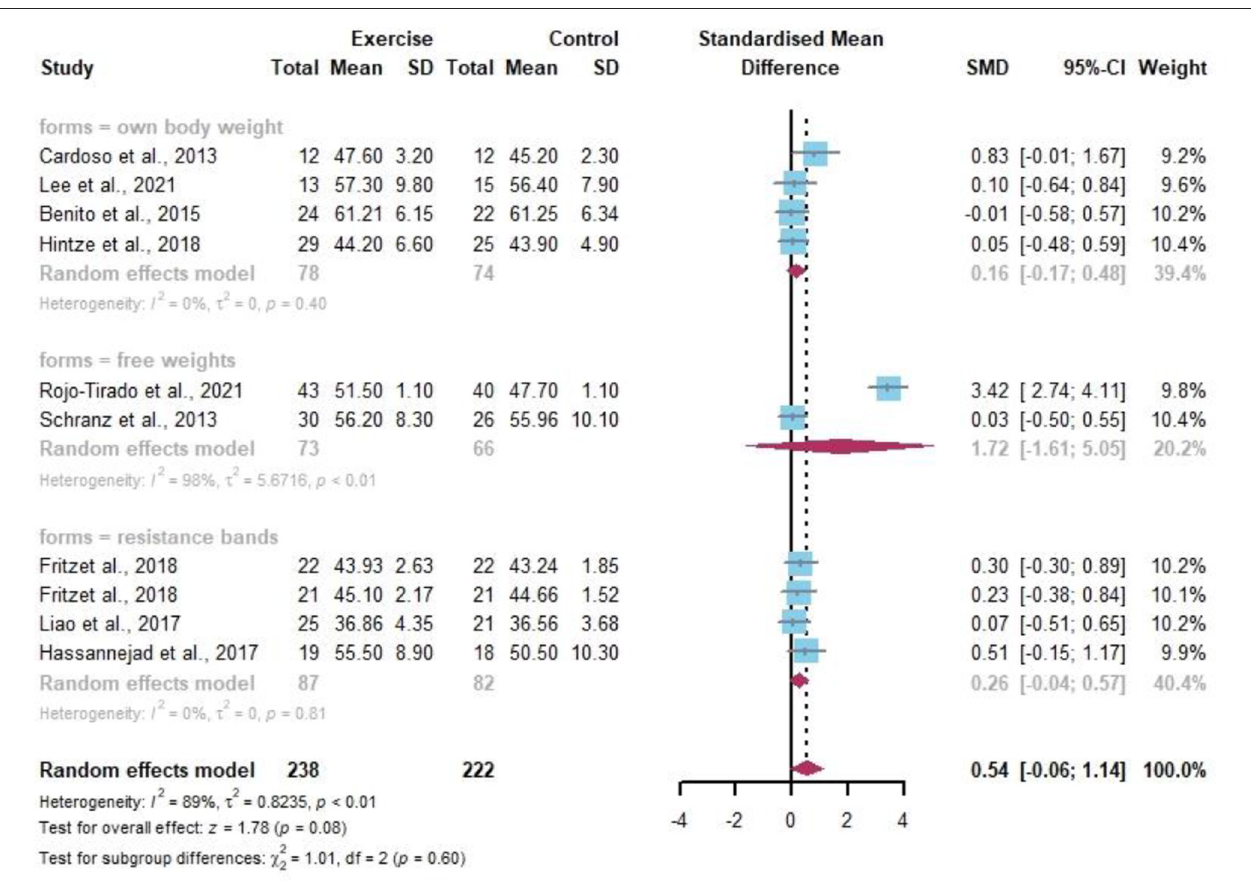
FIGURE 8 | Meta-analysis of effects of different resistance exercise forms on FFM of overweight and/or obese